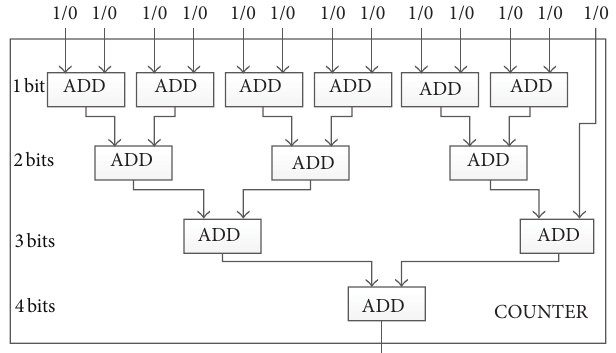
Figure 4: An example of COUNTER with 𝑁 𝑇 = 13 .